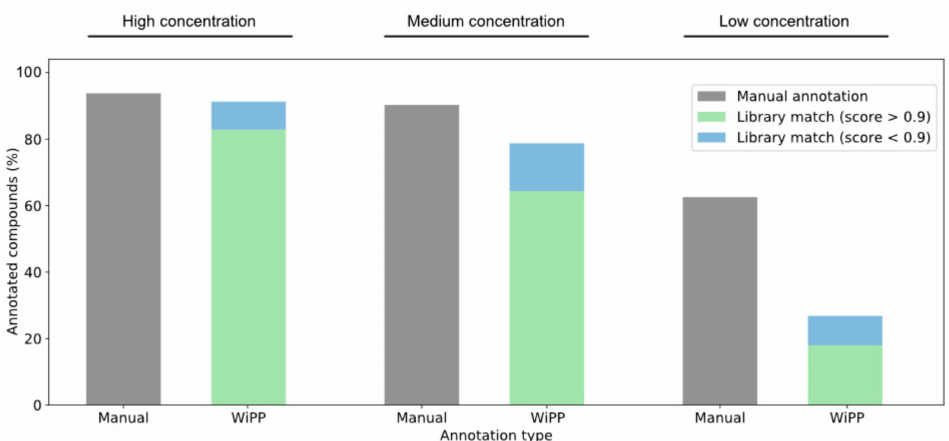
Figure 2. Number of metabolites detected and annotated manually or automatically by WiPP compared to the number of compounds present in the three concentrations of dataset 1.